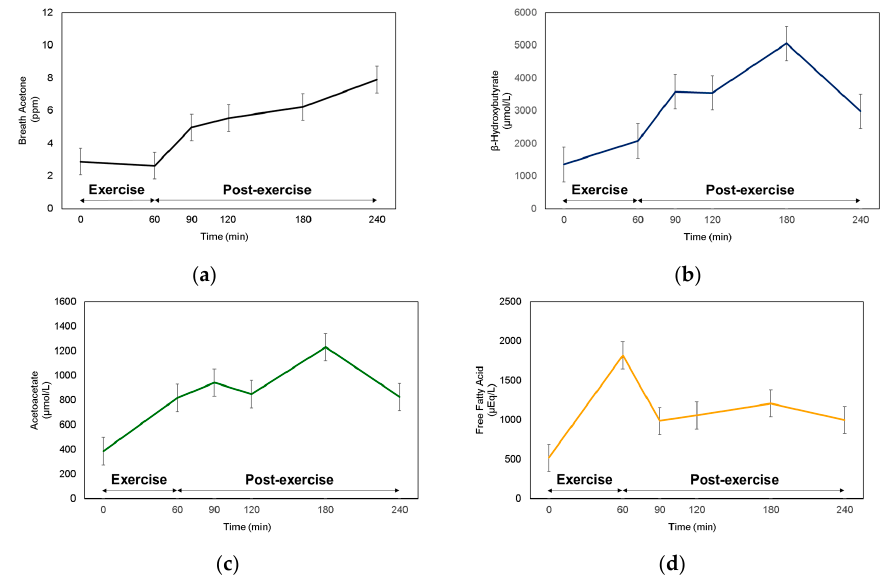
Figure 2. Monitoring of ( a ) Breath acetone, ( b ) β -hydroxybutyrate, ( c ) Acetoacetate, and ( d ) Free fatty acid.